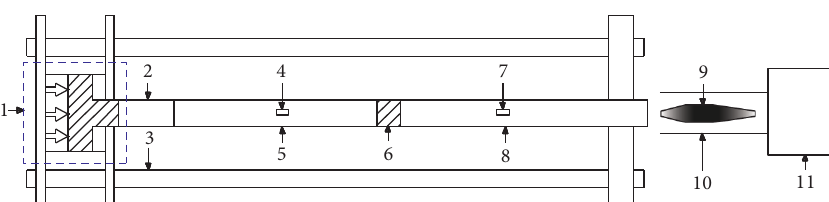
Figure 2: Structure diagram of the test load.1, pressure loading unit; 2, buffer bar; 3,support; 4, strain gauge A2; 5, transmission bar; 6, rock specimen; 7, strain gauge A1; 8, incident bar; 9, heterotype impact hammer; 10, launch cavity; 11, gas